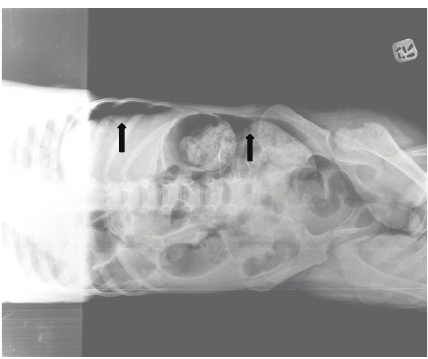
Figure 2: Lateral decubitus radiograph shows air movement within abdominal